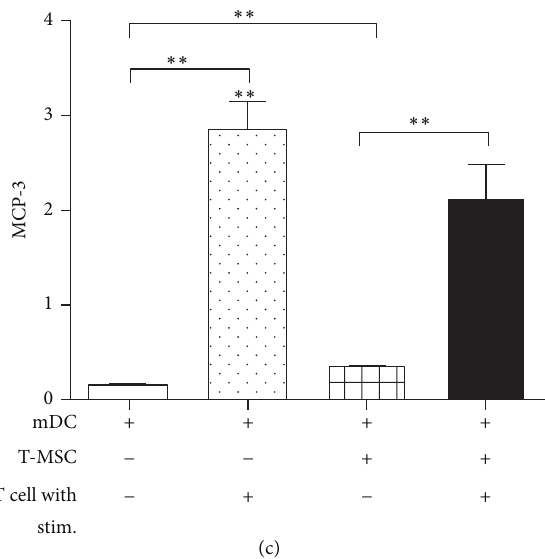
Figure 4: T-MSCs inhibited the release of GM-CSF, IL-6, MCP-1, and RANTES from mature DCs. (a) T cells were cocultured with mature DCs in the presence of T-MSCs. Conditioned medium was collected and subjected to Cytokine Array. (b) Plate arrangement of the Cytokine Array and cytokine spots, which show increased expression, are highlighted with a red box. (c) Expression changes were quantified and significant decreases in GM-CSF, RANTES, interleukin-6 (IL-6), and monocyte chemoattractant protein-1 (MCP-1) were observed when mature DCs and T cells were cocultured with